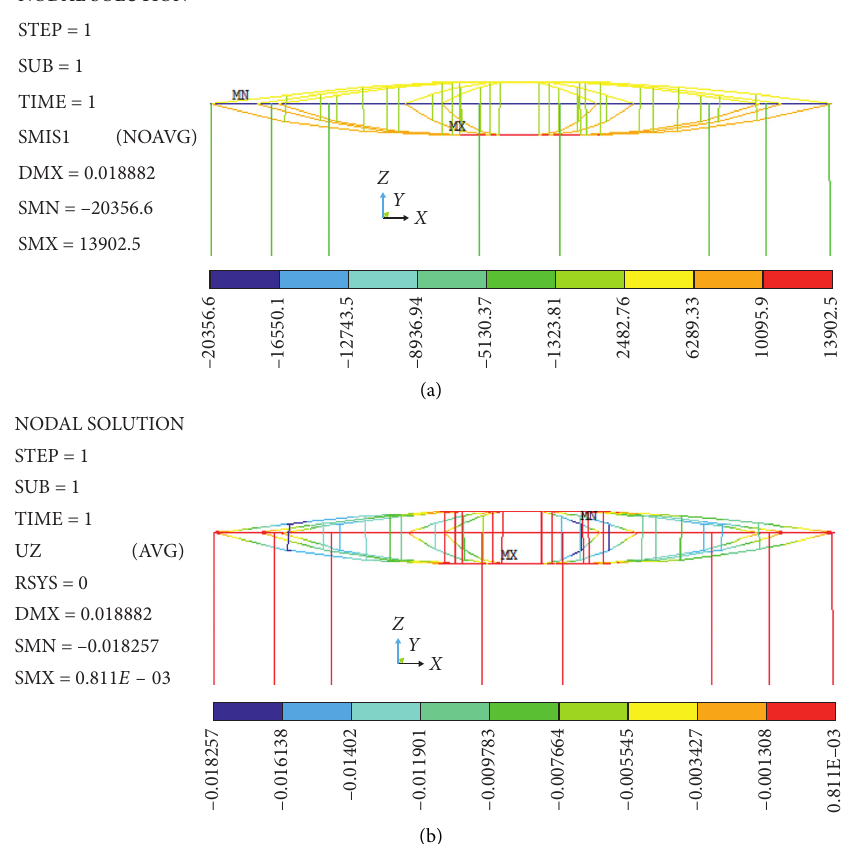
Figure 12:1.2 constant load+full span 1.4 live load real-time simulation analysis diagram. (a) Model internal force diagram (N). (b) Model displacement diagram